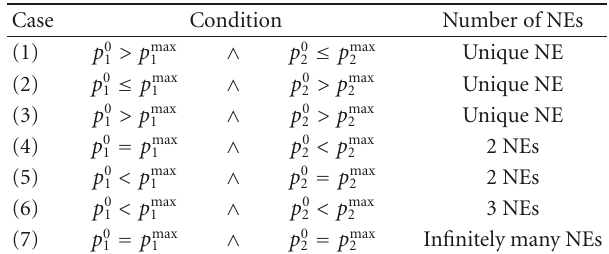
Figure 6: Illustration of the number of NEs in di ff erent interference regions. Table 1: Conditions for the number of